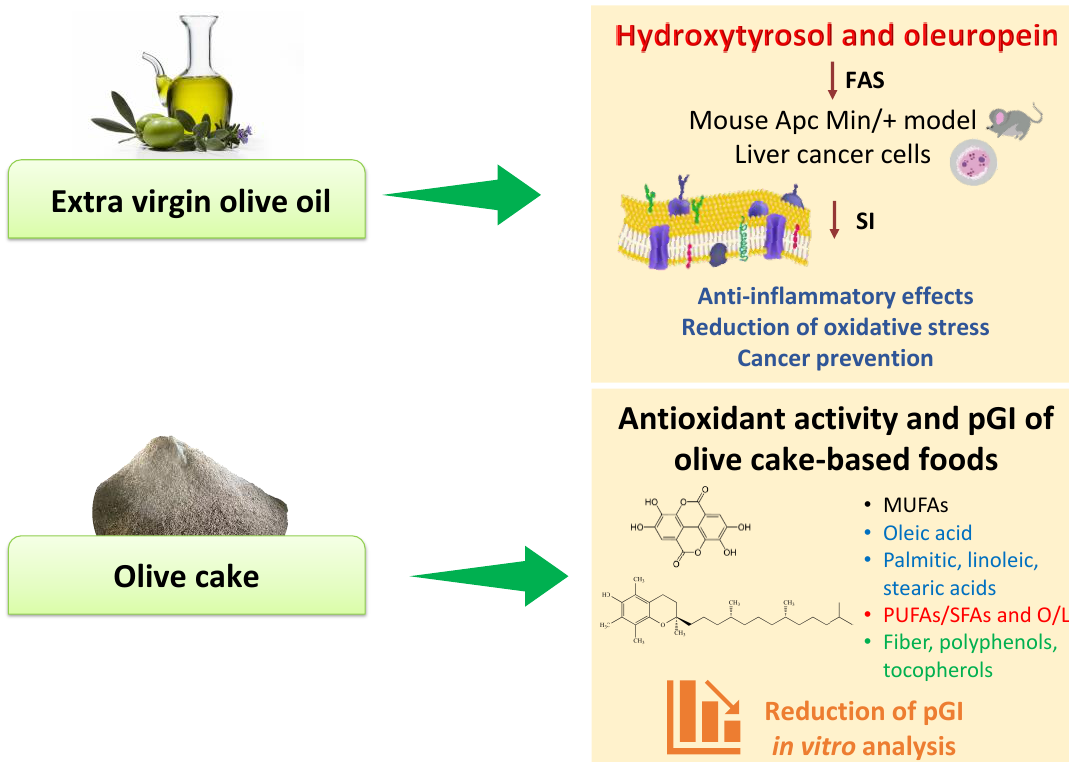
Figure 3. In vitro effects of extra virgin olive oil and olive cake. Abbreviations: FAS, fatty acid synthase; L, linoleic acid; MUFAs, monounsaturated fatty acids; O, oleic acid; pGI, predicted glycemic index; PUFAs, polyunsaturated fatty acids; SFAs, saturated fatty acids; SI, saturation index.